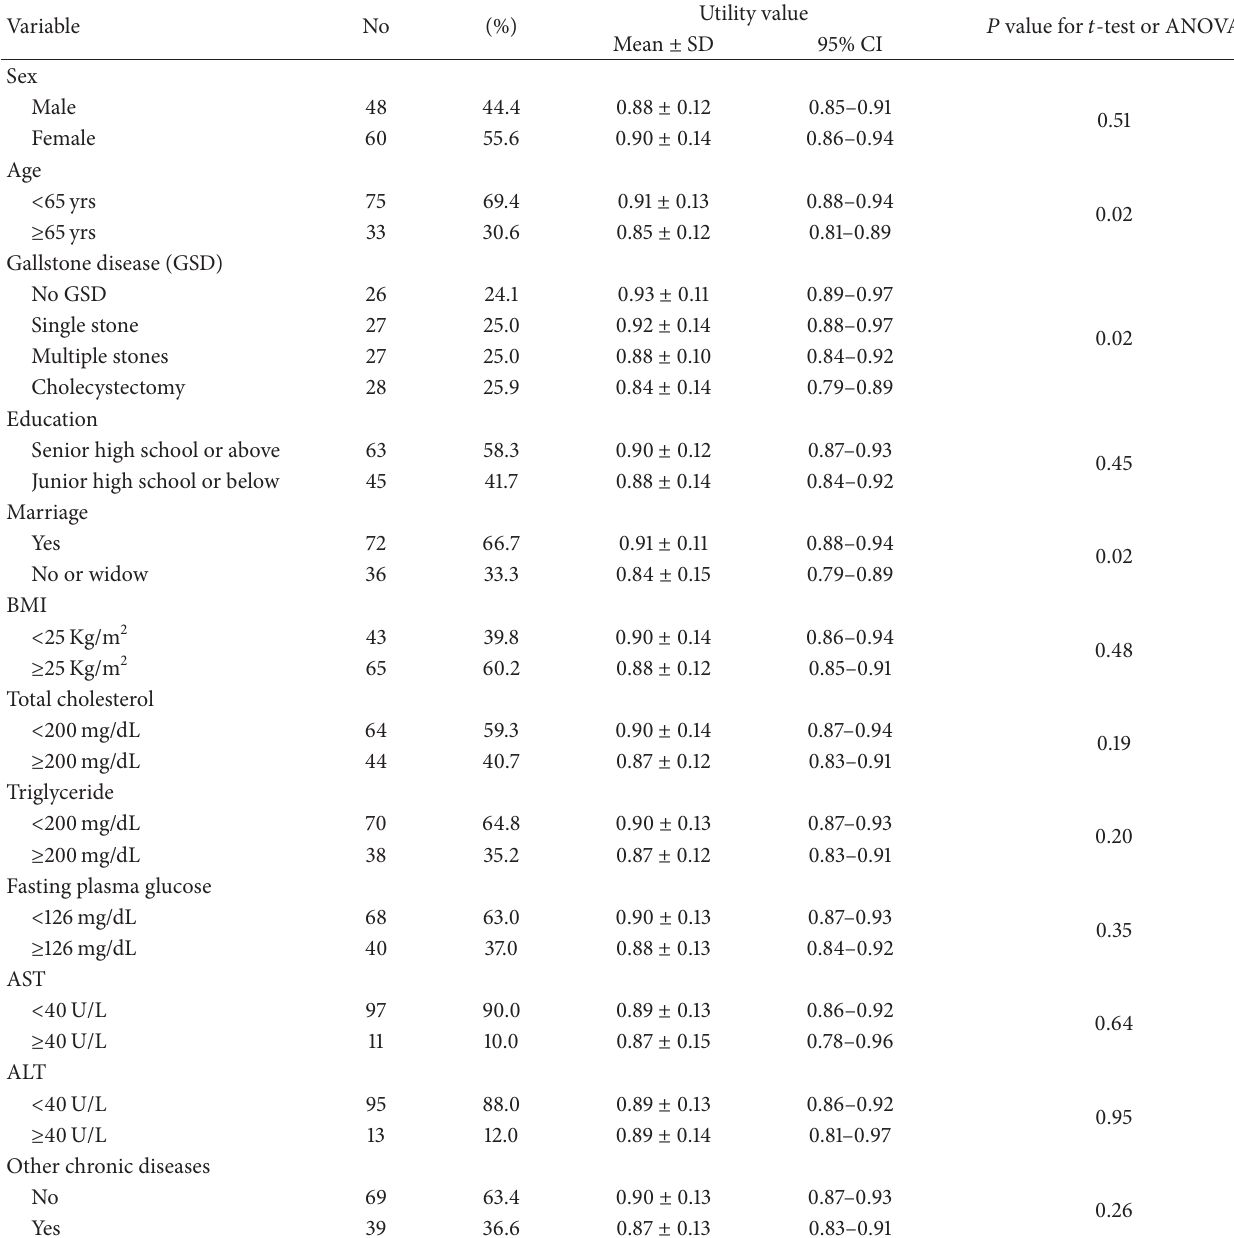
Table 3: Univariate analysis of utility values for outpatient clinics participants ( 𝑛 = 108